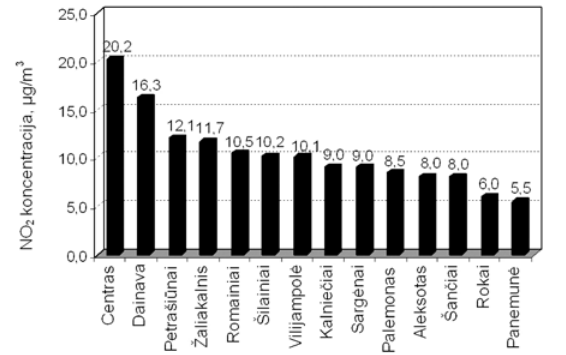
Fig. 2. Distribution of Kaunas environmental monitoring observation plots in city territory